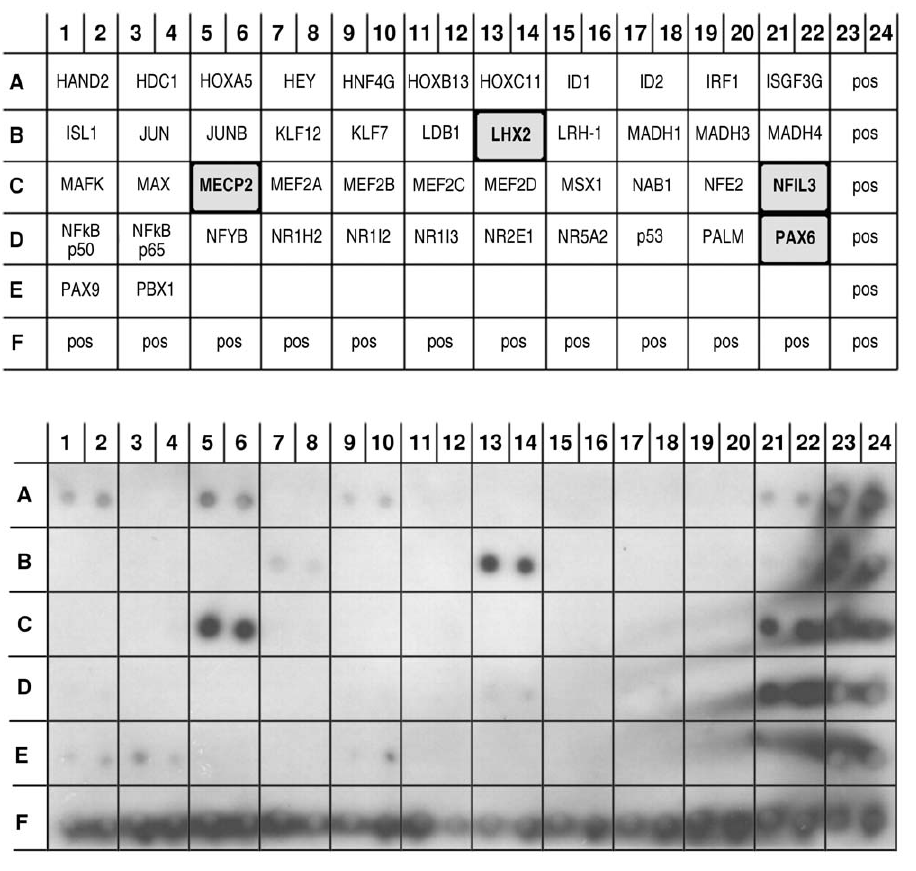
Figure 7. Ankrd2 promoter DNA can interact with some transcription factors that also interact with the Ankrd2 protein. The upper panel is a schematic diagram of the Transcription Factor Array II (Panomics/Affymetrix, USA) showing the positions of the spotted His tagged TF proteins. The bottom panel shows the TF protein array membrane after hybridization with the biotinylated DNA of the Ankrd2 promoter ( 2 1,173 to 2 4 bp). The Ankrd2 promoter DNA bound strongly to MeCP2, LHX2, NFIL3 and PAX6 and more weakly to HAND2 and HOXA5. The positive controls are at the bottom and right edge of the membranes. The TF proteins that interact with the Ankrd2 promoter are highlighted.